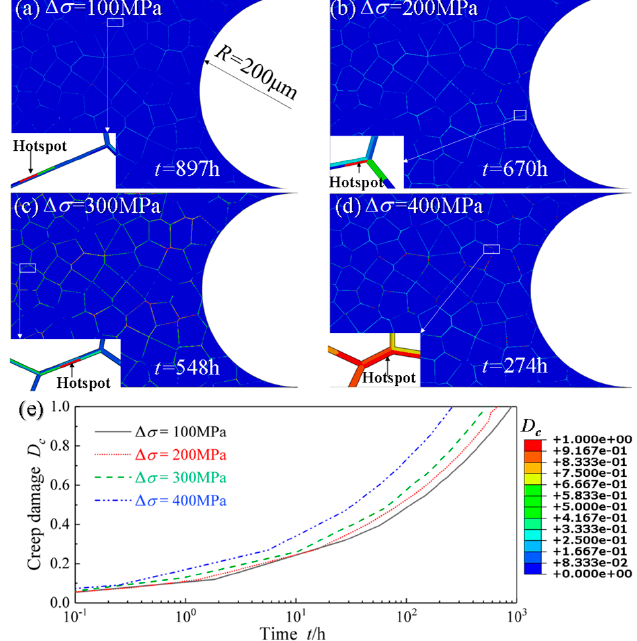
Figure 8. Distribution of creep damage D c of notch specimen ( R = 200 μ m) with 4 stress ranges: ( a ) 100 MPa; ( b ) 200 MPa; ( c ) 300 MPa; ( d ) 400 MPa and ( e ) the evolution curves of D c of the hotsopts from ( a – d ).